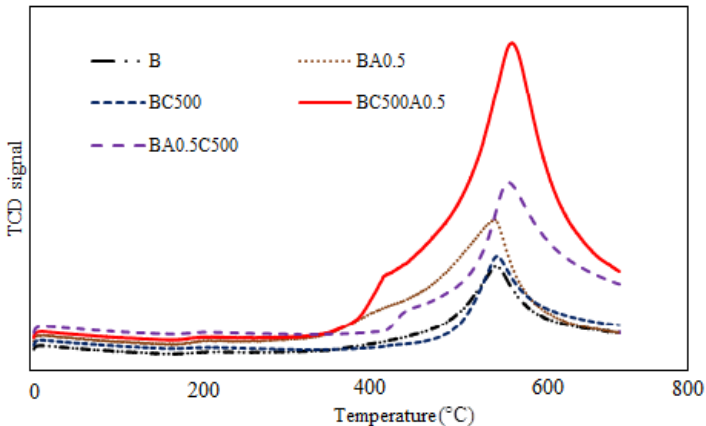
Figure 4. NH 3 -TPD profiles for bentonite and modified bentonite.